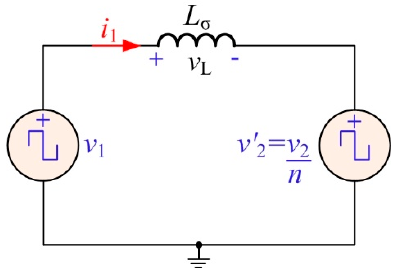
Figure 8. Primary-referred equivalent circuit of the two-port converter.